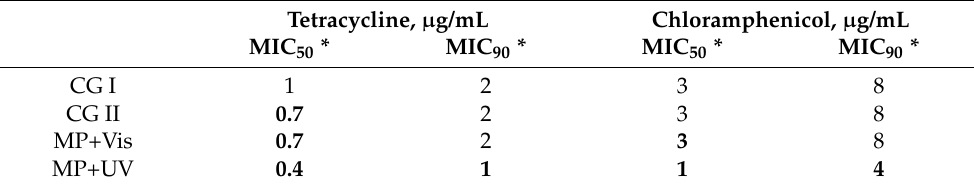
* MIC 50 and MIC 90 correspondingly represent the minimal antibiotic amount that is needed to in- activate 50% and 90% of initial bacteria.